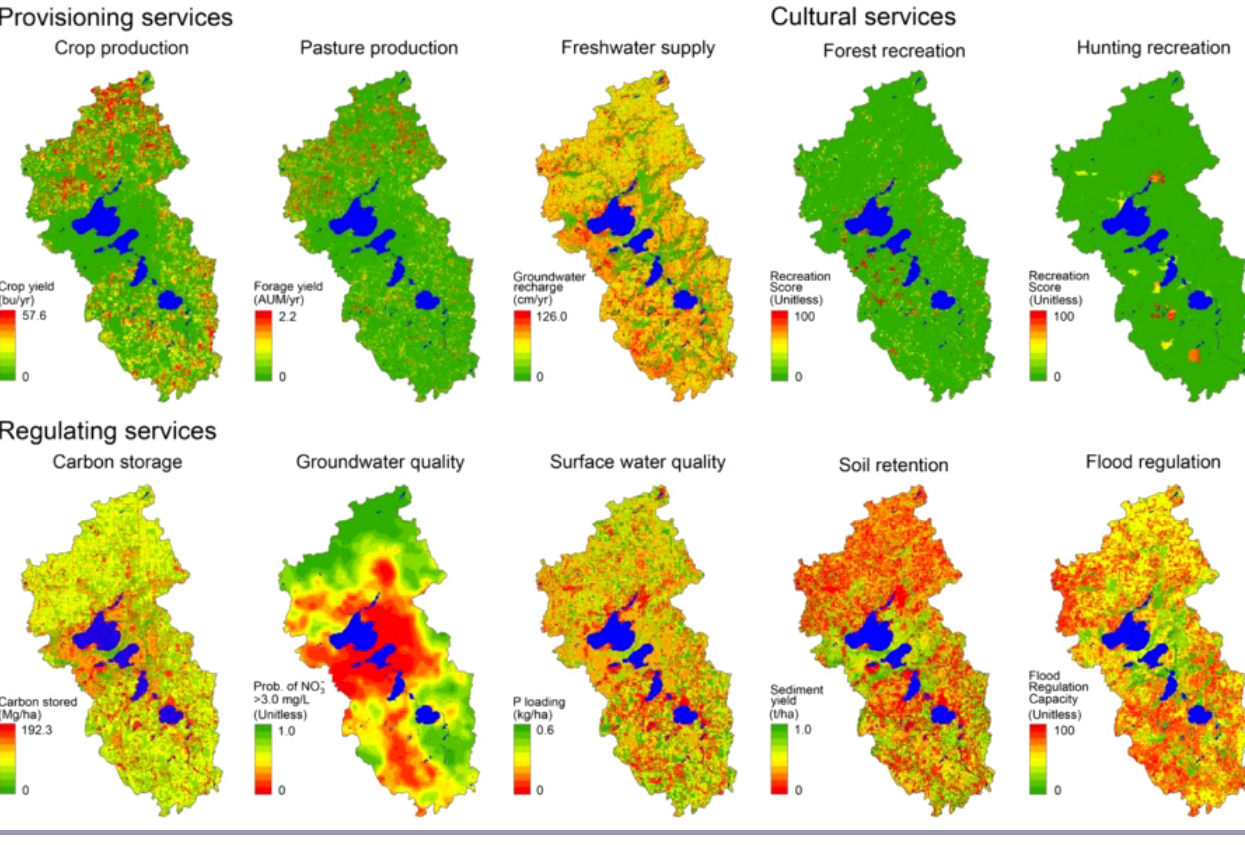
Fig. 3. Spatial distributions of 10 ecosystem services in the Yahara watershed, Wisconsin, for the baseline year of 2006. The gradation from red to green indicates areas with high to low supply of ecosystem services. The production of individual ecosystem services varied substantially across the landscape and were distinct in their geographic distributions. Reprinted with permission from Qiu and Turner (2013).